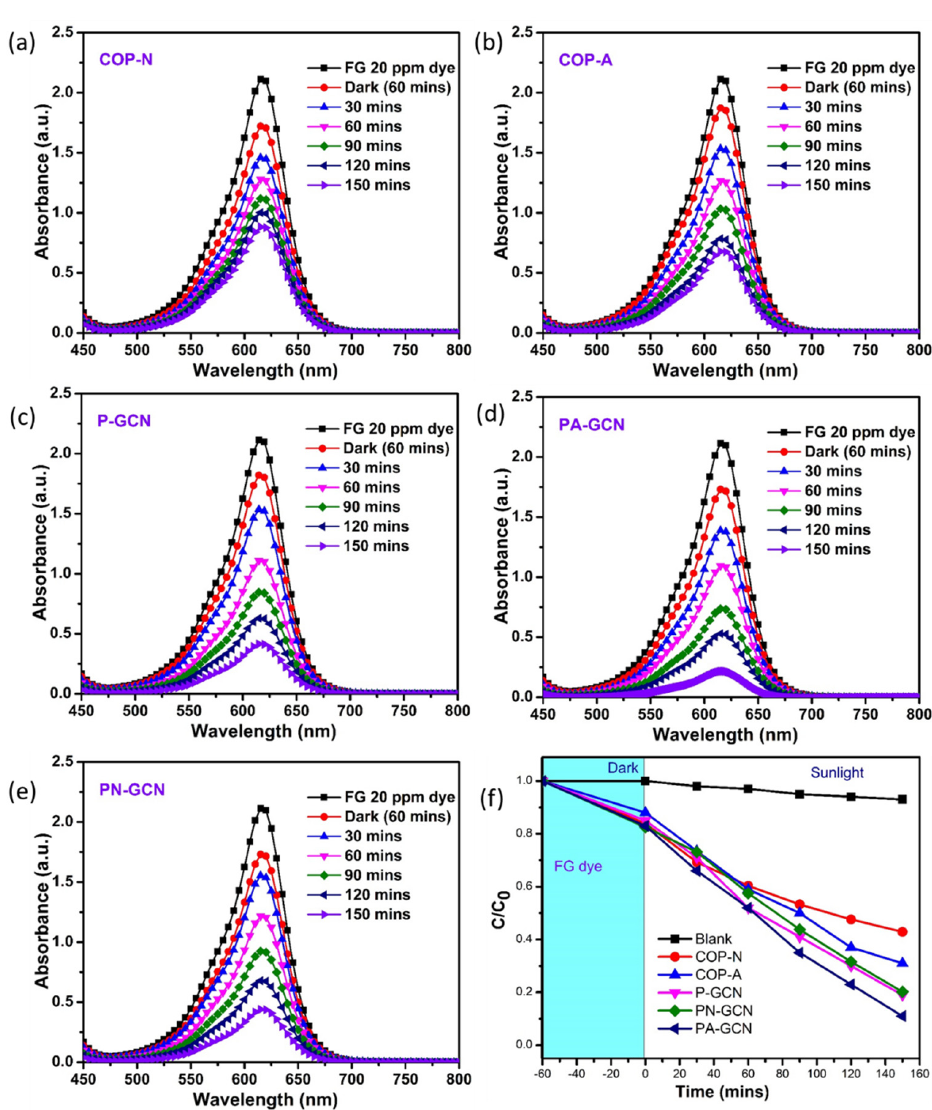
Figure 10. UV-Vis spectra of FG for the Metal free catalysts ( a ) COP-N, ( b ) COP-A, ( c ) P-GCN, ( d ) PA-GCN, ( e ) PN-GCN and ( f ) efficiency plot (C/C 0 ) of FG. ( d ) PA-GCN, ( e ) PN-GCN and ( f ) efficiency plot (C/C 0 ) of FG.